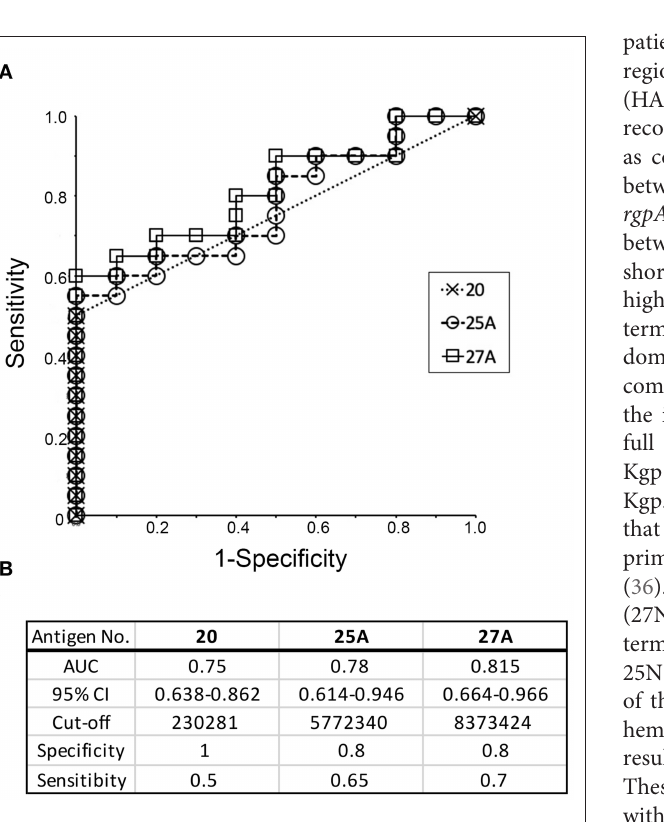
FIGURE 5 | Receiver operative characteristic (ROC) curve analysis to evaluate the diagnostic capacity of individual recombinant antigens (20, 25A, and 27A) to distinguish between periodontitis patients and healthy individuals. (A) ROC curves were generated as described by Ekuseru-Toukei 2010 (Social Survey Research Information Co., Ltd.) using the spot intensities from the dot blot analysis ( Figure 4 ). (B) The values of AUC with 95% confidence interval (CI) and sensitivity/specificity with optimal cut-offs are presented in the lower